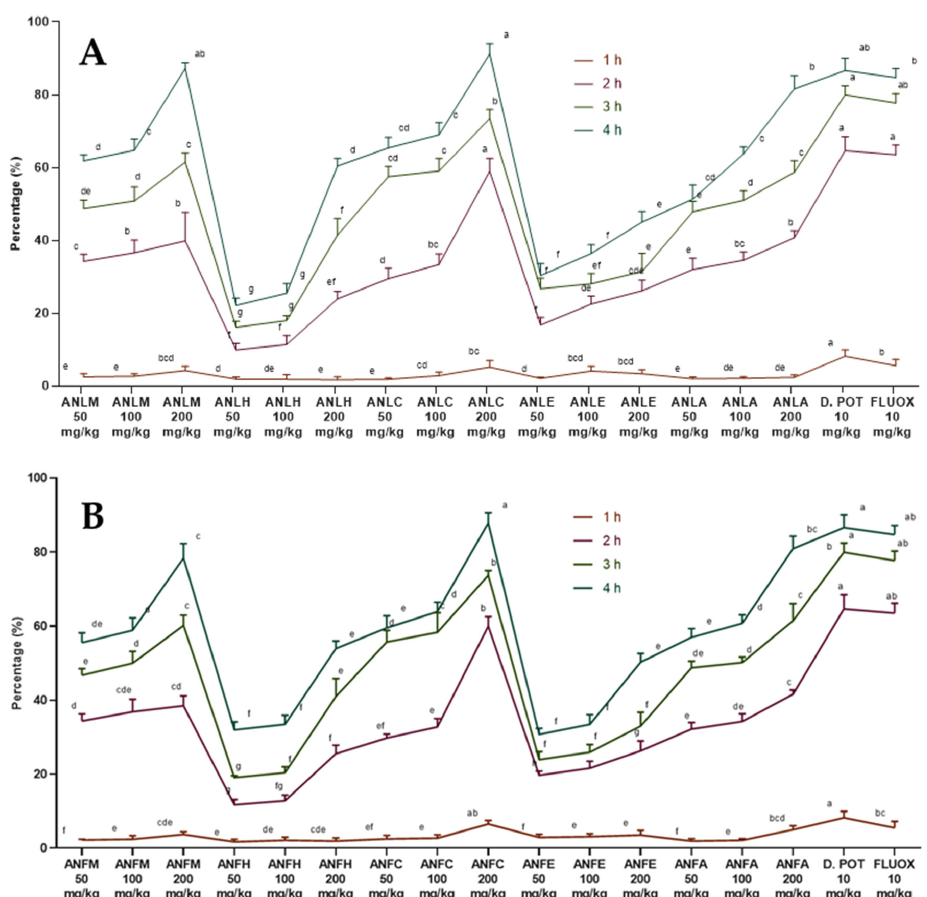
Figure 1. Percentage inhibition of A. nitida on carrageenan-induced paw edema in rats ( A ) A . nitida leaves methanolic extract (ANLM), A . nitida leaves n-hexane fraction (ANLH), A . nitida leaves chloroform fraction (ANLC), A . nitida leaves ethyl acetate fraction (ANLE), A . nitida leaves aqueous fraction (ANLA), and ( B ) A . nitida fruit methanolic extract (ANFM), A . nitida fruit n-hexane fraction (ANFH), A . nitida fruit chloroform fraction (ANFC), A . nitida fruit ethyl acetate fraction (ANFE), A . nitida fruit aqueous fraction (ANFA). D.POT: Diclofenac potassium; FLUOX: Fluoxetine. Data were analyzed using seven replicates as mean ± SD by a two-way ANOVA followed by Bonferroni’s test. Different letters represent the significance level of p < 0.05 with respect to all other samples “a, b” with reference to positive controls, “c” with reference to methanolic extract and “d, e, f, g” with reference to n-hexane, chloroform, ethyl acetate and aqueous fractions, respectively. 2.2.2. Freunds’ Complete Adjuvant Induced Arthritis The observations obtained from this test are reported in Figure 2 and Tables S3 and S4. After edema induction (14 days), ANLC and A . nitida fruit chloroform fraction (ANFC) at all doses (50, 100 and 200 mg/kg) showed markedly ( p < 0.01) decreased ede- ma. The edema was further significantly ( p < 0.01) repressed after 21 days by chloroform, methanol and aqueous fractions of A. nitida leaves and fruit. However, multiple com- parisons of many treatments showed that ANLC and ANFC at 200 mg/kg almost equally decreased in edema, as shown by diclofenac potassium and fluoxetine. However, the decrease in edema of these dosages was considerably higher ( p < 0.01) relative to other samples.